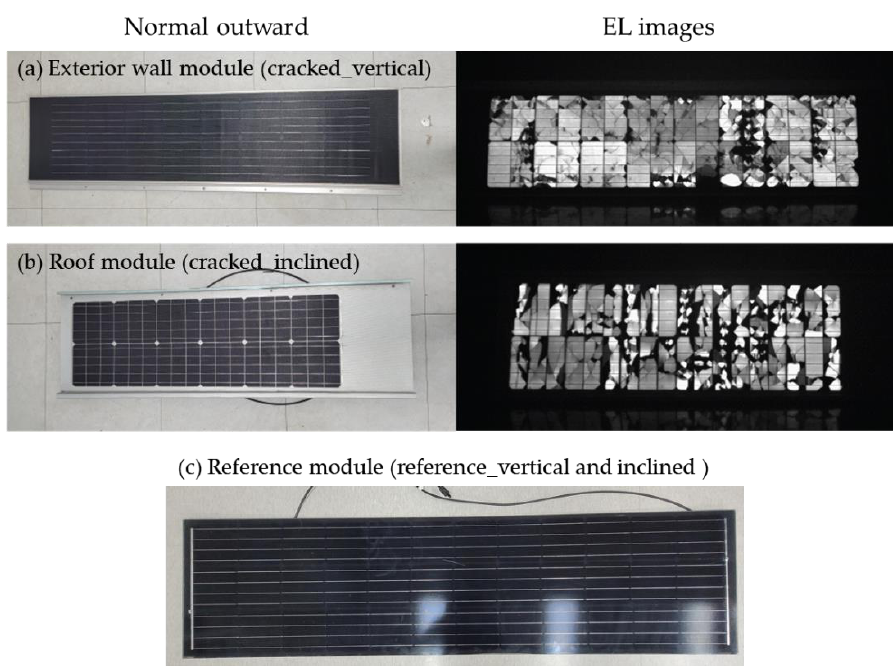
Figure 3. Actual outward and EL images of cracked modules and an outward image of the reference module: ( a ) exterior wall, ( b ) roof, and ( c ) common BIPV modules .